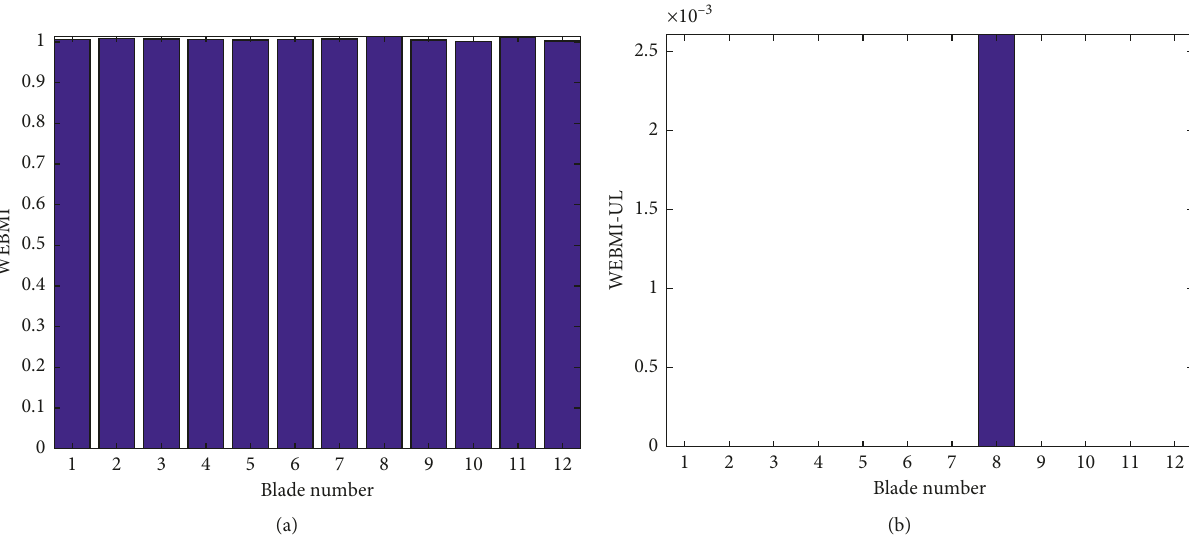
Figure 17: Optical sensor results for the added mass located at blade 8. (a) WEBMI and (b) WEBMI-UL.